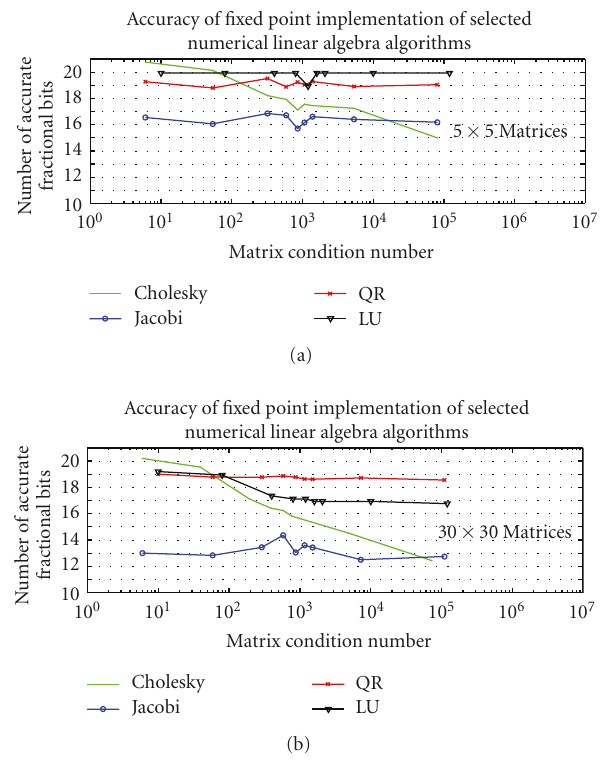
Figure 15: Number of accurate fractional bits. Fixed point imple- mentation of selected numerical linear algebra algorithms (results are for 5 × 5 and for 30 × 30 matrices with di ff erent condition num-